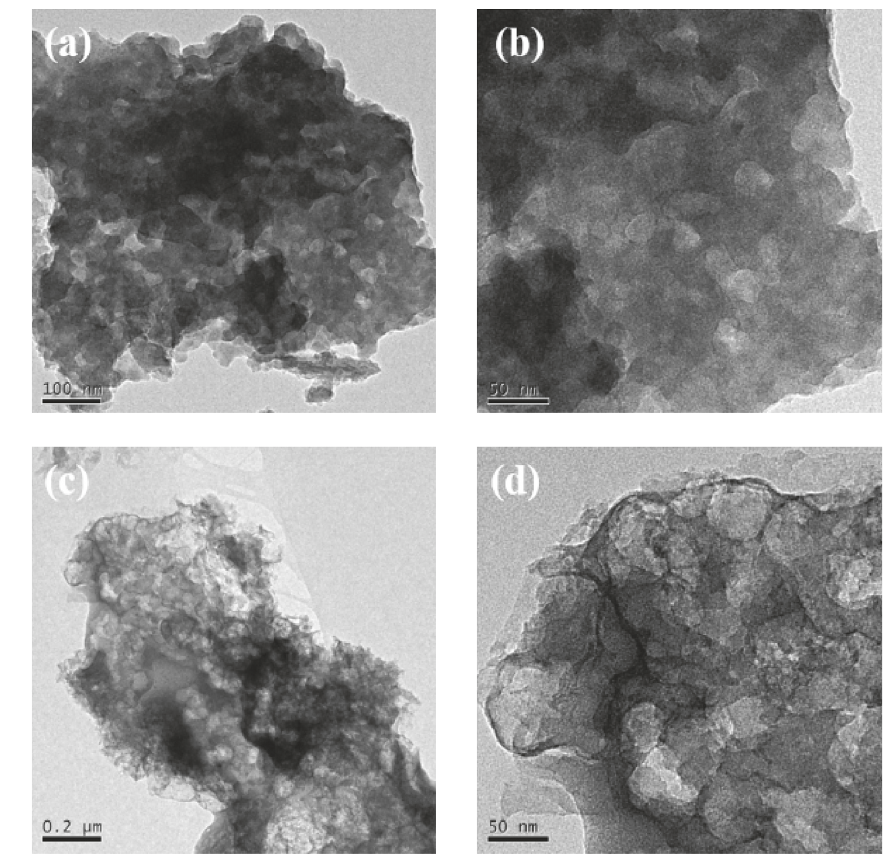
Figure 4: TEM of PRC-600 ° C (a), (b) and DPRC-600 ° C (c),